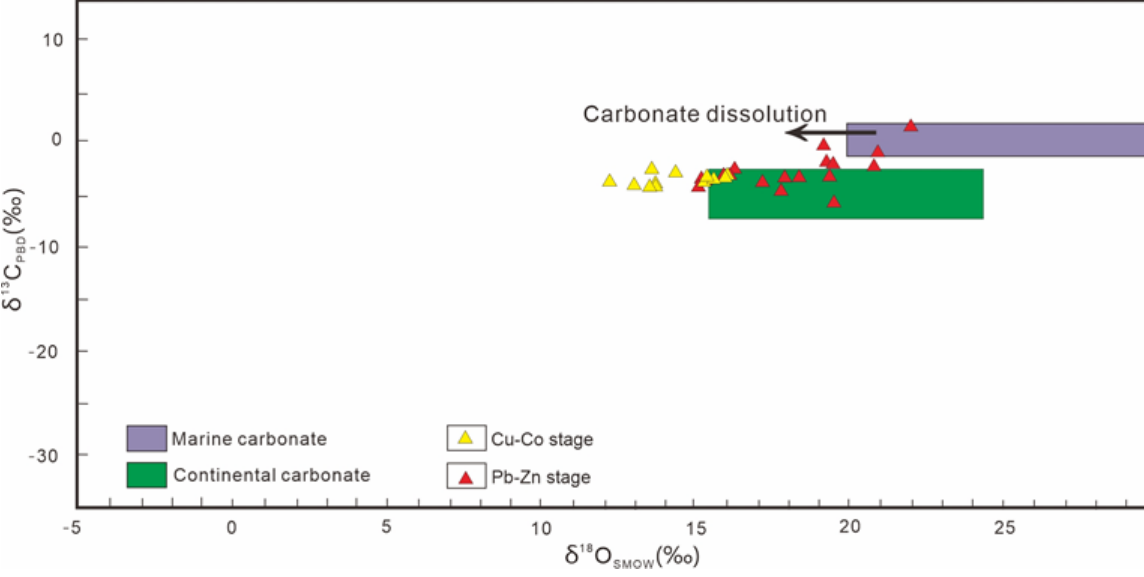
Figure 8. Plots of calculated δ 18 O SMOW versus δ 13 C PDB from various samples of the Baiyangping Cu – Co – Pb – Zn deposit.